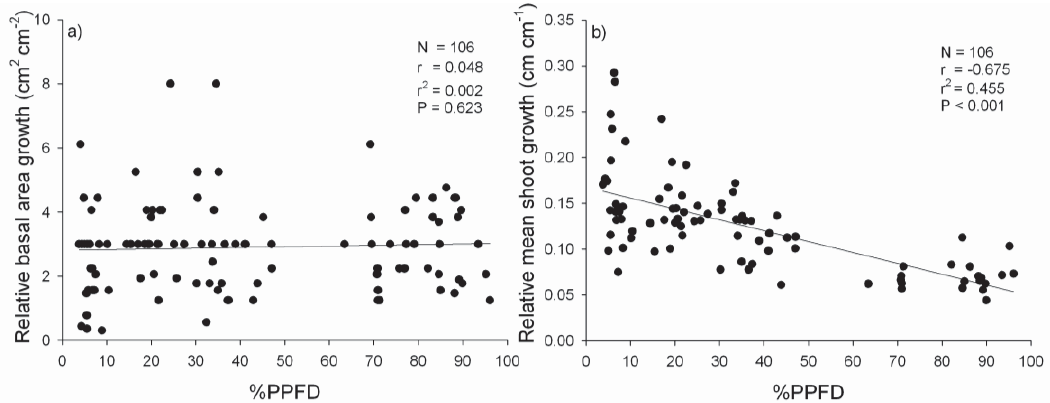
Figure 5. Relationships between ( a ) relative basal area growth (cm 2 cm − 2 ) and %PPFD; ( b ) relative mean shoot growth (cm cm − 1 ) and %PPFD in planted P. uviferum seedlings.